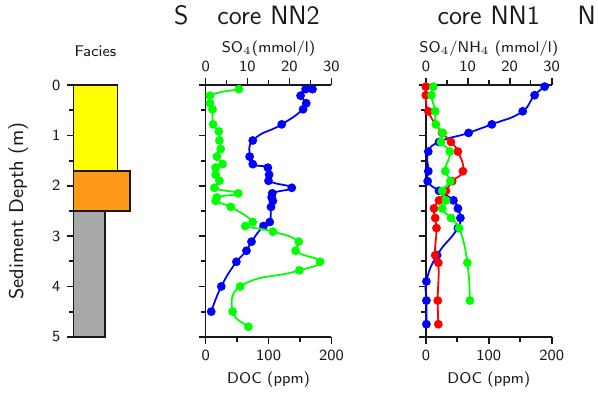
Fig. 2. Lithology and geochemical inventory at the study site. The N-S oriented transect covers 40m at the nothern rim of the Neuhar- lingersieler Nacken tidal flat. Facies association according to Chang et al. (2006b): sandy intertidal flat and channel deposits ( yellow ), shell lag deposits ( orange ), and saltmarsh/mudflat deposits ( gray ). Pore water data of DOC ( green ), SO 4 ( blue ), and NH 4 ( red ) show sulfate depletion between 1 and 2mbsf accompanied by a NH 4 peak (NN1). Core NN1 shows pore water data from 2005 (one of three parallel